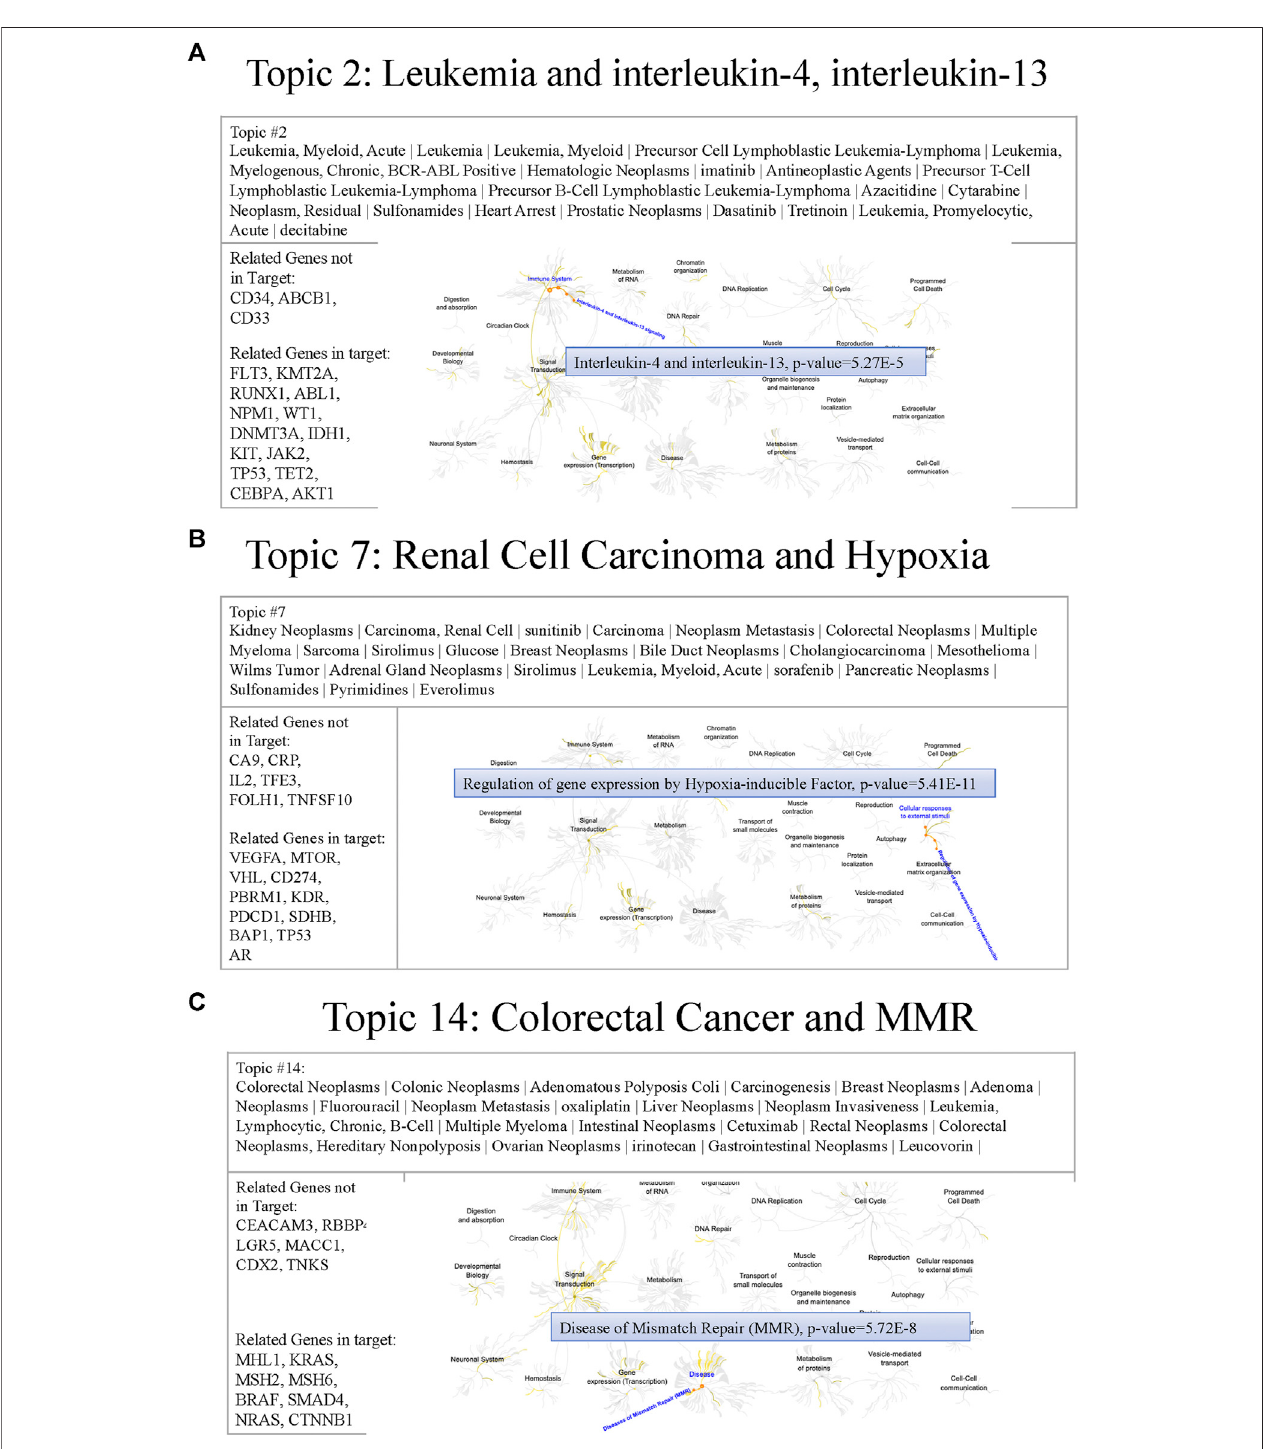
FIGURE7| Examplesofcancertopicscontainingrelevanttextfeatures,genes,andpathways (A) Figureshowingthetextfeatures,genes,andpathwaysoftopic2. Cancer types (e.g., leukemia) and inhibitors (e.g., imatinib) were reported in this topic. Reactome pathway analysis revealed that the related genes of the MSK-IMPACT panelintopic2(e.g.,FLT3)wereinvolvedininterleukin-4andinterleukin-13signaling( p (cid:2) 5.27e-5). (B) Figureshowingthetextfeatures,genes,andpathways oftopic7. Text features including cancer types (e.g., kidney neoplasms) and inhibitors (e.g., sorafenib) implied the relationship between topic seven and kidney cancer. The hypoxiapathway enriched byrelated genes(e.g.,VHL)oftheMSK-IMPACT panelintopic7( p (cid:2) 5.41e-11)played acrucial roleinthegovernance ofcancerstemcellsof renal cancer. (C) Figure showing the text features, genes, and pathways of topic 14. Many text features containing cancer types (e.g., colorectal neoplasms) and inhibitors(e.g.,oxaliplatin)indicatedtheassociationbetweentopic14andcoloncancer.RelatedgenesoftheMSK-IMPACTpanelintopic14(e.g.,MLH1)wereinvolved in the mismatch repair pathway ( p (cid:2) 5.72e-8).